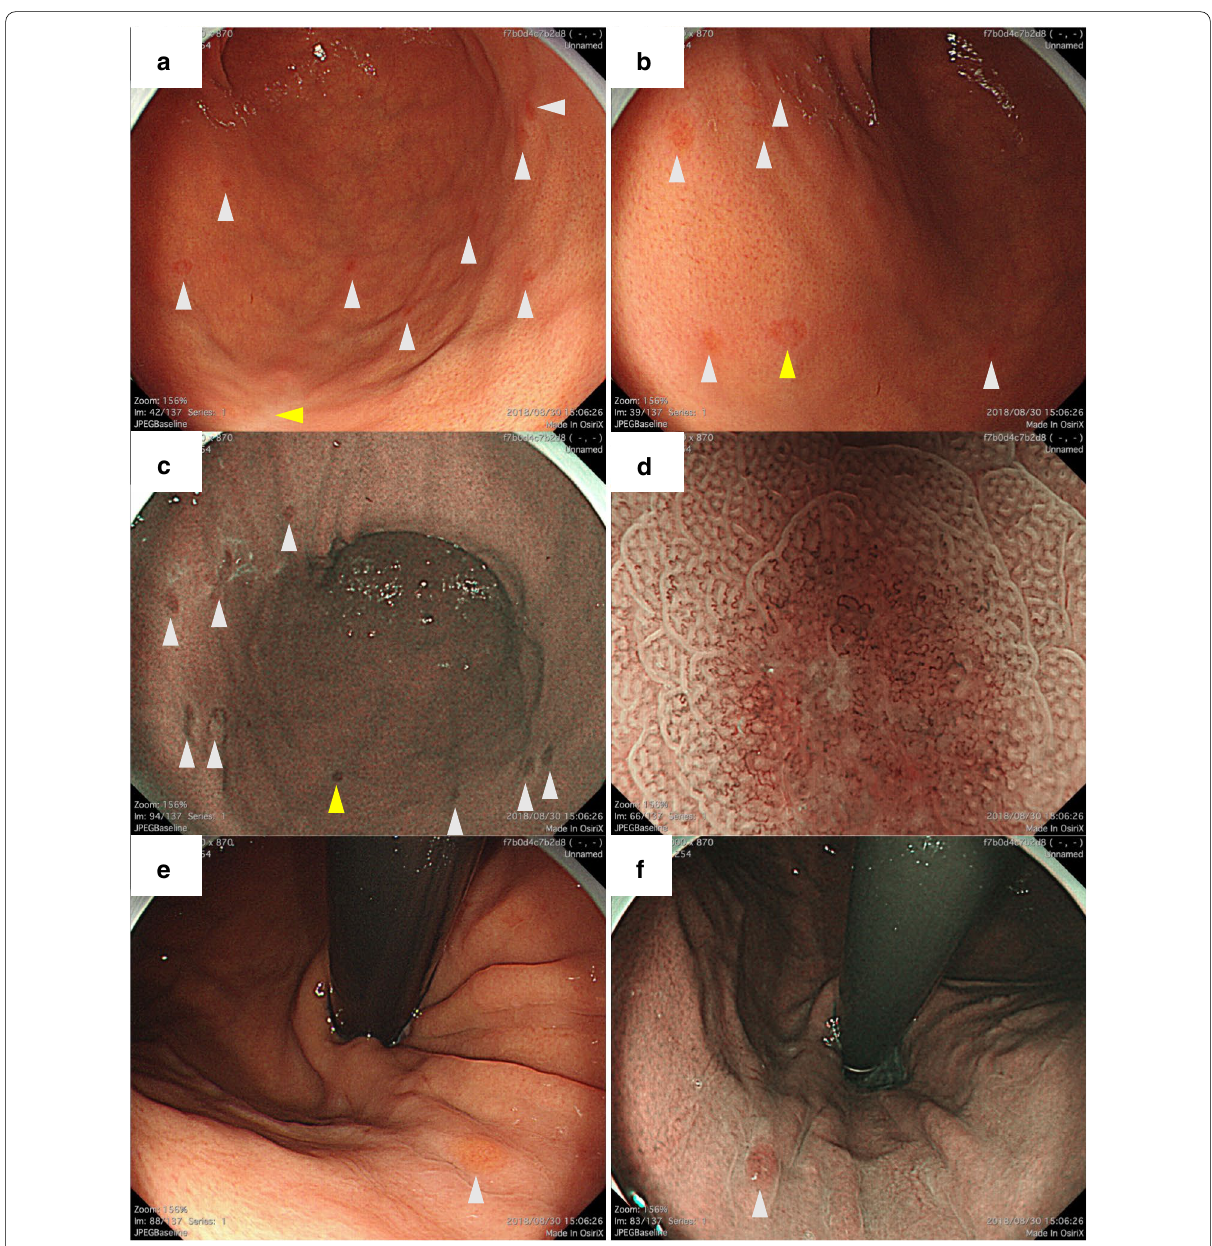
Fig. 1 Endoscopic image in the preoperative state. a and b : White light images of the middle-third and lower-third of the gastric body. More than ten small flat erosive lesions less than 5 mm in diameter were widely scattered (white and yellow arrowheads). By narrow-band imaging ( c ), those lesions were observed as brownish lesions (white and yellow arrowheads). d A magnified image of the lesion identified by a yellow arrowhead. A corkscrew-like irregular microvascular pattern with normal grandular structure was observed. e and f : White light and narrow-band images of lesions located at the upper gastric